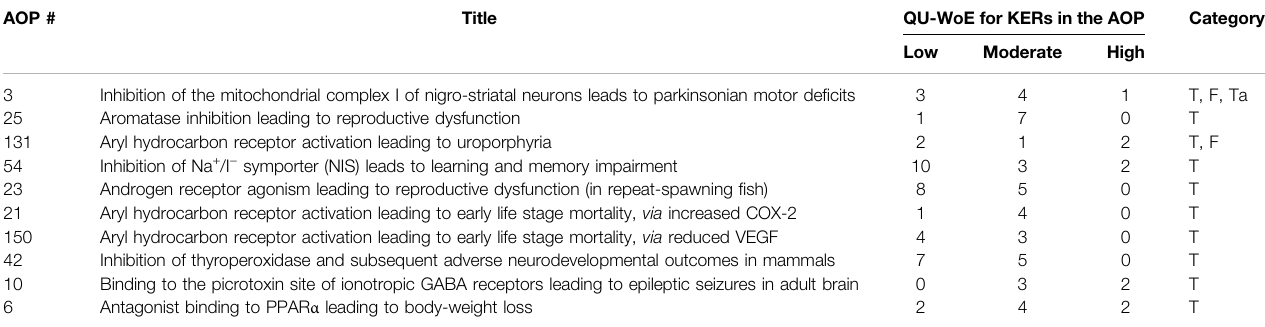
TABLE1| CategorizationofAOPswithOECDStatusbasedonpresentationofquantitativedatainthequantitativeunderstandingsectionoftheKERdescription.TotalKERs include KERs between non-adjacent KEs. T = Written in text only with cited references, F = Includes fi gures extracted from articles, Ta = References are provided in a tabulated form. QU-WoE, Weight of Evidence under the quantitative understanding section.